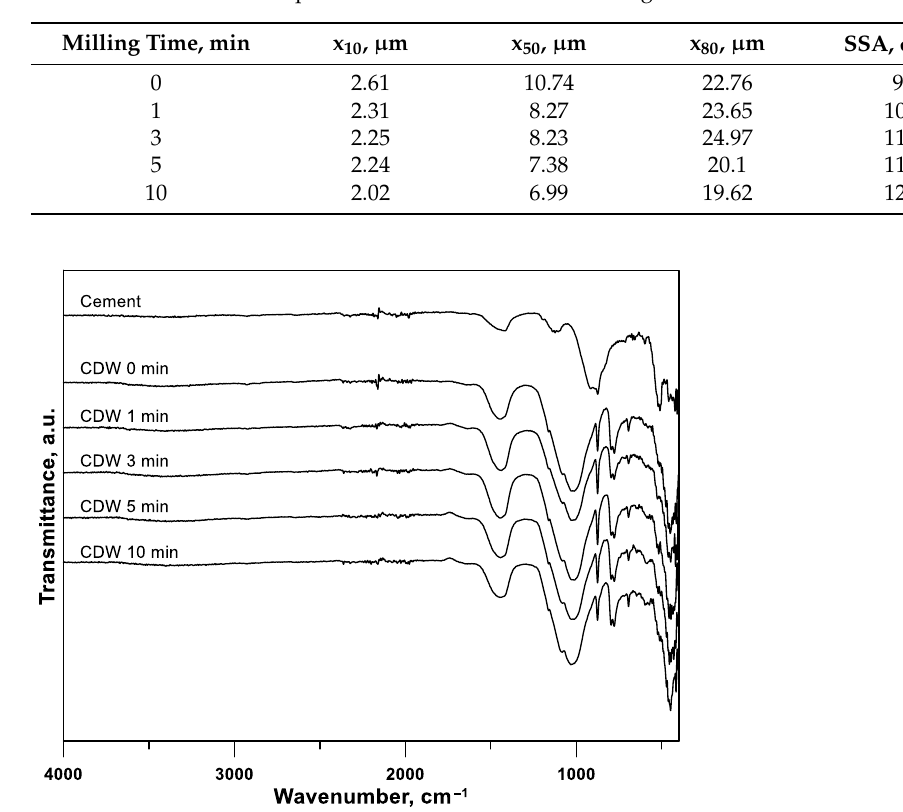
Figure 1. The FTIR spectra of the cement and ground CDW samples.